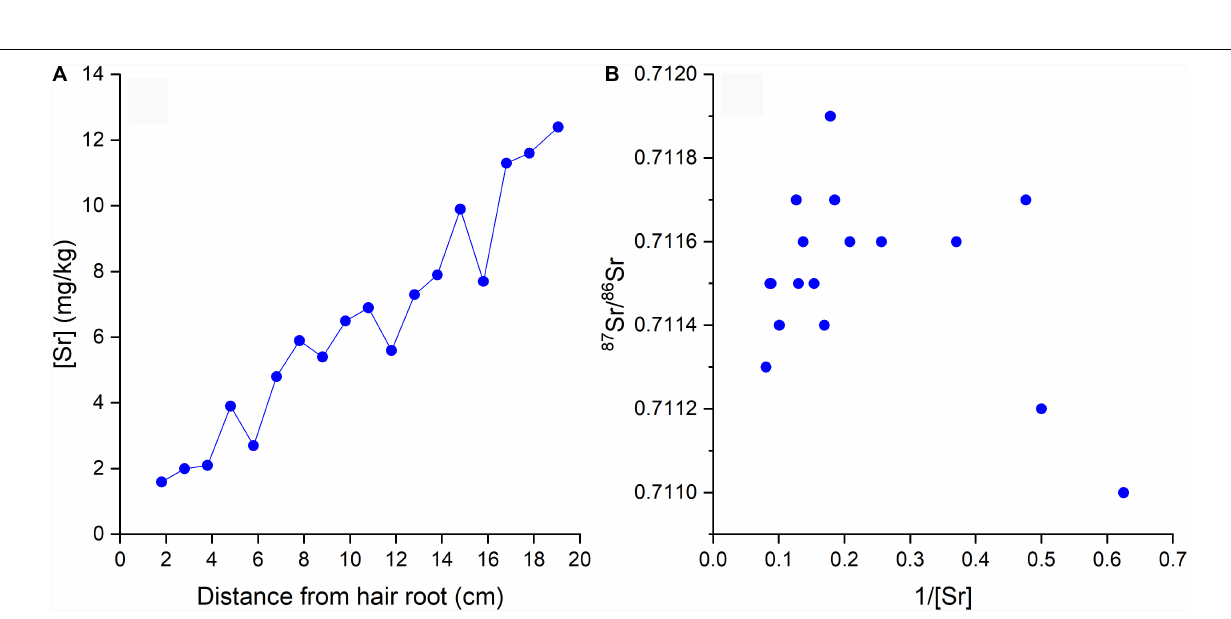
Frontiers in Ecology and Evolution |